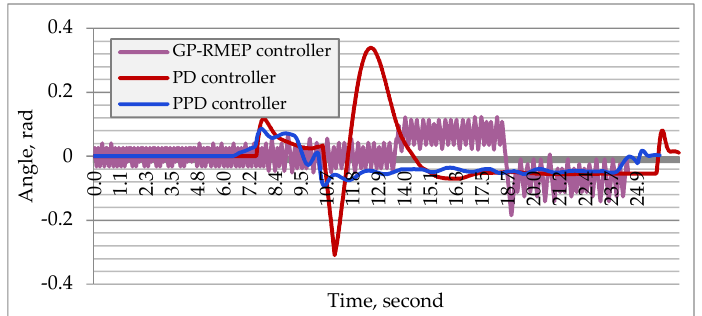
Figure 10. Dynamics of the steering angle for different types of controllers—the controller input is µ = 0.3, 0.95 V cr